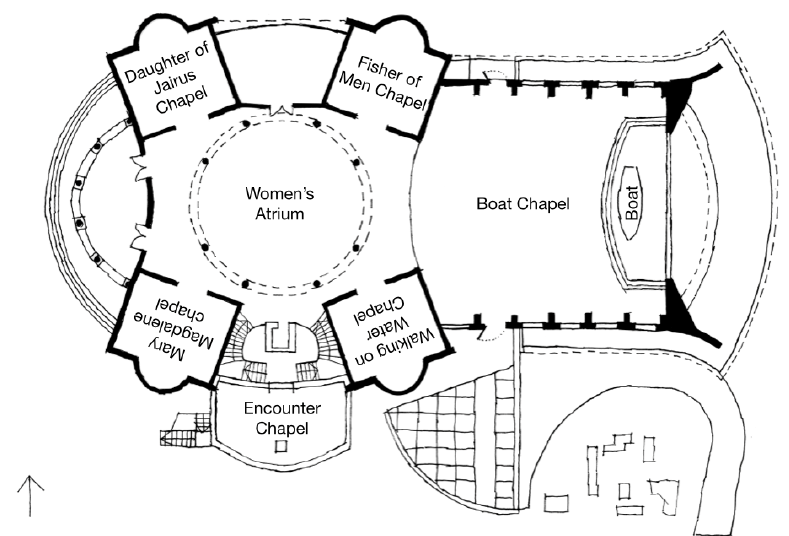
Figure 3. Ground Plan of Duc in Altum Worship Center. (plan: Naomi Simhony after de la Garza).